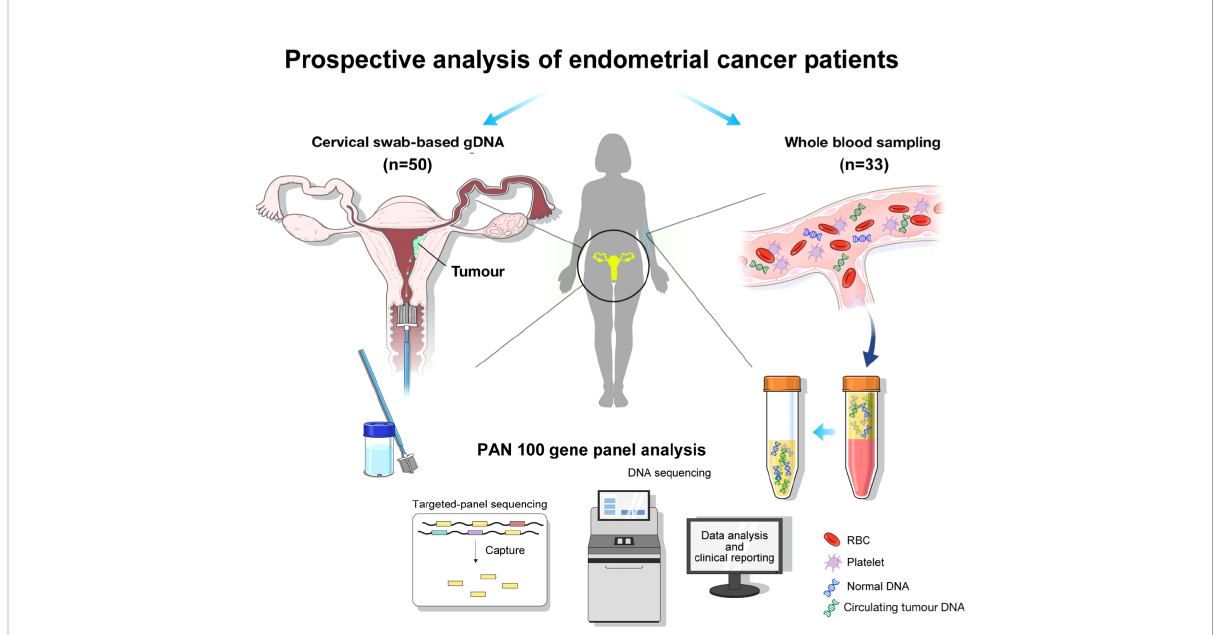
FIGURE 1 Graphical summary of the analysis fl ow: the collection of genomic DNA (gDNA) based on cervical swab and circulating tumor DNA (ctDNA) based on whole blood sampling, followed by genomic pro fi ling with Pan100